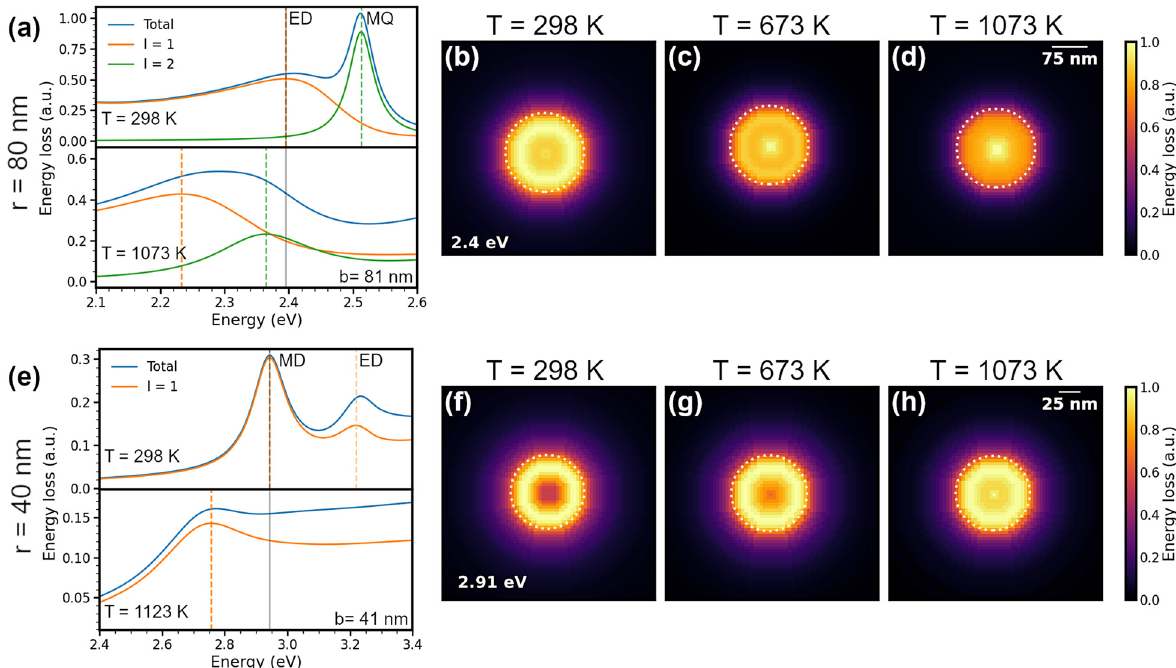
Figure 3: Thermal near-field tuning of silicon Mie modes. (a) Multipole decomposition of the EELS signal into different azimuthal contributions l for a particle with r = 80 nm. The decomposition is performed at two temperatures for the impact parameter b = 81 nm. (b)–(d) Experimental EELS maps of a particle with r = 82 . 4 ± 1 . 9 nm for a fixed energy of 2.4 eV (ED at the room temperature) at different temperatures. (e) Multipole EELS decomposition at two temperatures for a particle with r = 40 nm with impact parameter b = 41 nm. (f)–(h) Experimental EELS maps of a particle with r = 42 . 2 ± 0 . 7 nm for a fixed energy of 2.91 eV (MD at the room temperature) at different